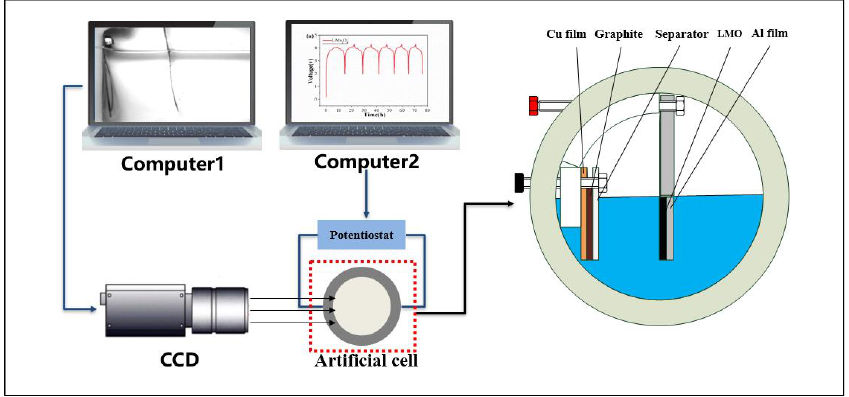
Figure 2. Schematics of the chemo-mechanical measurement system and the artificial cell (cross-section).